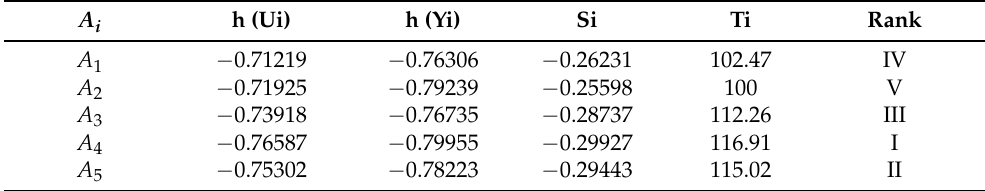
Table 11. Scores and ranking of